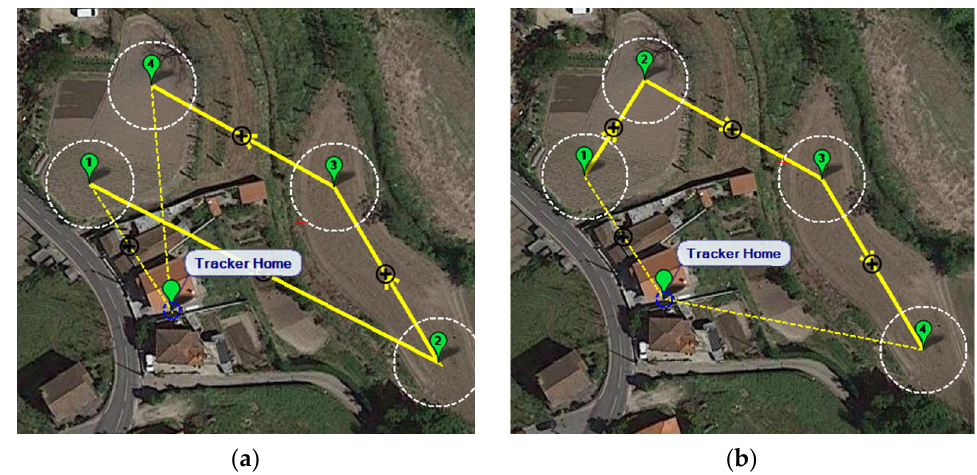
Figure 6. Example of the importance of minimizing the path between PoIs: ( a ) Without the optimization function ( b ) With the optimization function.